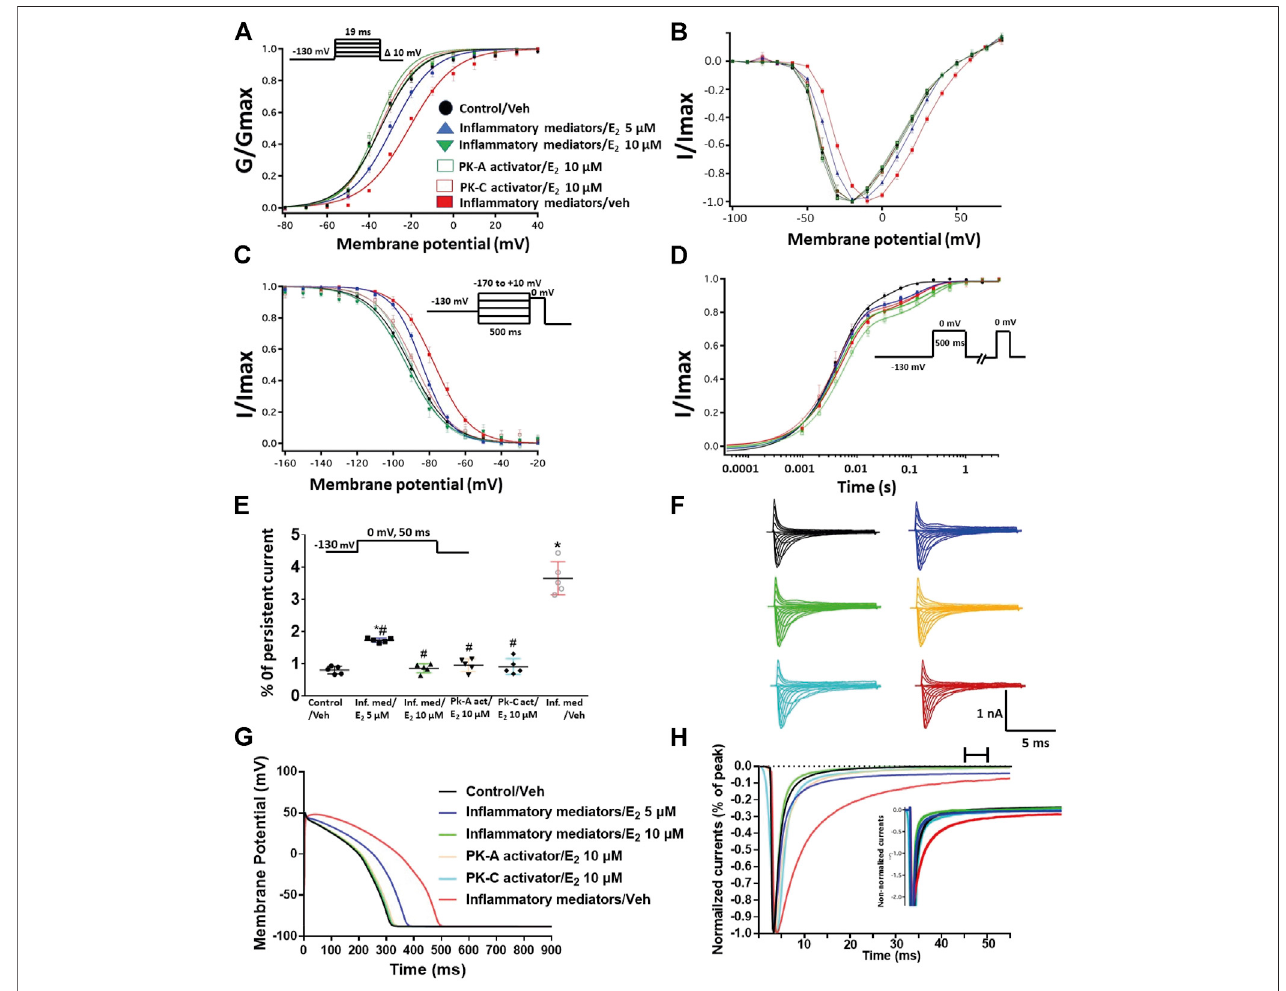
FIGURE 7 | (A) Effect of E 2 (5 or 10 µM) on conductance curve of Nav1.5 transfected CHO cells incubated in in fl ammatory mediators (for 24 h), PK-A activator (CPT-cAMP;1 µMfor 20 min)orPK-C activator (PMA; 10 nM,for 20 min)withtheinsert showing theprotocol (n (cid:2) 5,each). (B) IV curves (C) Effect ofE 2 (5 or10 µM)on SSFI of Nav1.5 transfected CHO cells incubated in in fl ammatory mediators (for 24 h), PK-A activator (CPT-cAMP; 1 µM for 20 min) or PK-C activator (PMA; 10 nM, for 20 min)withtheinsertshowingtheprotocol( n (cid:2) 5,each). (D) EffectofE 2 (5or10 µM)onrecoveryfromfast inactivation ofNav1.5CHO transfectedcells incubated inin fl ammatorymediators(for24 h),PK-Aactivator(CPT-cAMP;1 µMfor20 min)orPK-Cactivator(PMA;10 nM,for20 min)withtheinsertshowingtheprotocol( n (cid:2) 5, each). (E) EffectofE 2 (5or10 µM)onthepercentageofpersistentsodiumcurrentsofNav1.5transfectedCHOcellsincubatedinin fl ammatorymediators(for24 h),PK-A activator (CPT-cAMP; 1 µM for 20 min) or PK-C activator (PMA; 10 nM, for 20 min) with the insert showing the protocol (n (cid:2) 5, each). (F) Representative families of macroscopiccurrents. (G) EffectofE 2 (5or10 µM)onthe Insilico actionpotentialdurationofNav1.5transfectedcellsincubatedinin fl ammatorymediators(for24 h),PK- A activator (CPT-cAMP; 1 µM for 20 min) or PK-C activator (PMA; 10 nM, for 20 min). (H) Representative persistent currents across conditions. Currents were normalized to peak current amplitude. Bar above current traces indicates period during which persistent current was measured. Inset shows non-normalized currents. * p < 0.05vs. corresponding “ Control/Veh ” values using one-way ANOVA alongwith posthoc testing. # p < 0.05 vs. corresponding “ in fl ammatory mediators/Veh ” values using Student ’ s